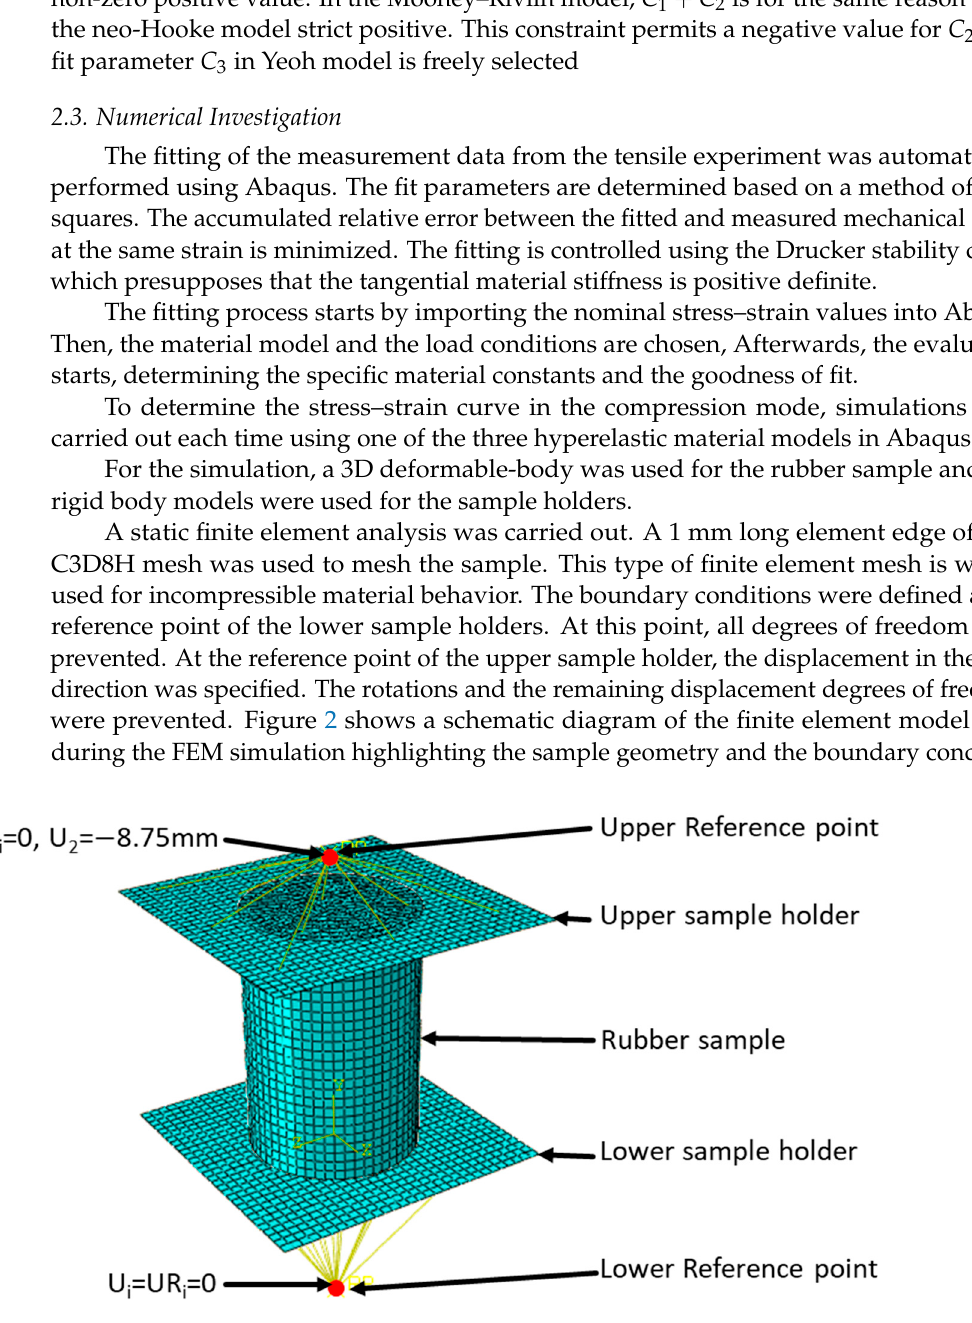
Figure 2. Schematic diagram of the finite element model used during the finite element method (FEM) simulation highlighting the sample geometry and the boundary conditions.